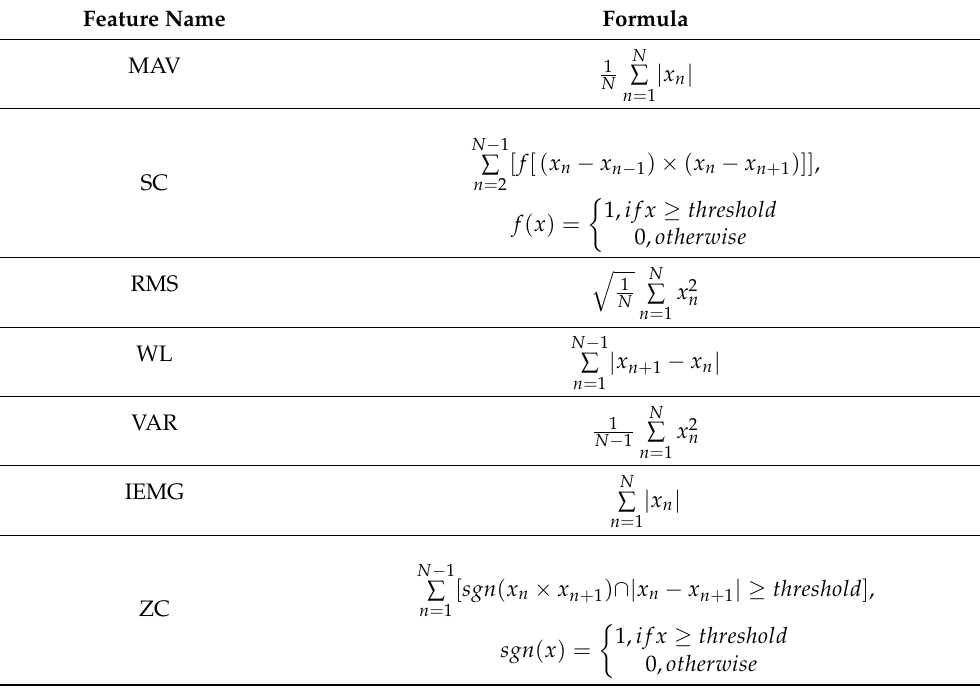
Table 2. Formulas for temporal domain